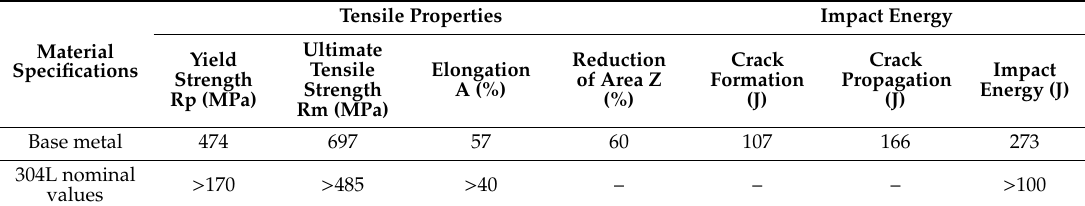
Table 2. Mechanical properties of the 304L base metal and nominal base metal properties (ASTM A240 / 240M; EN ISO